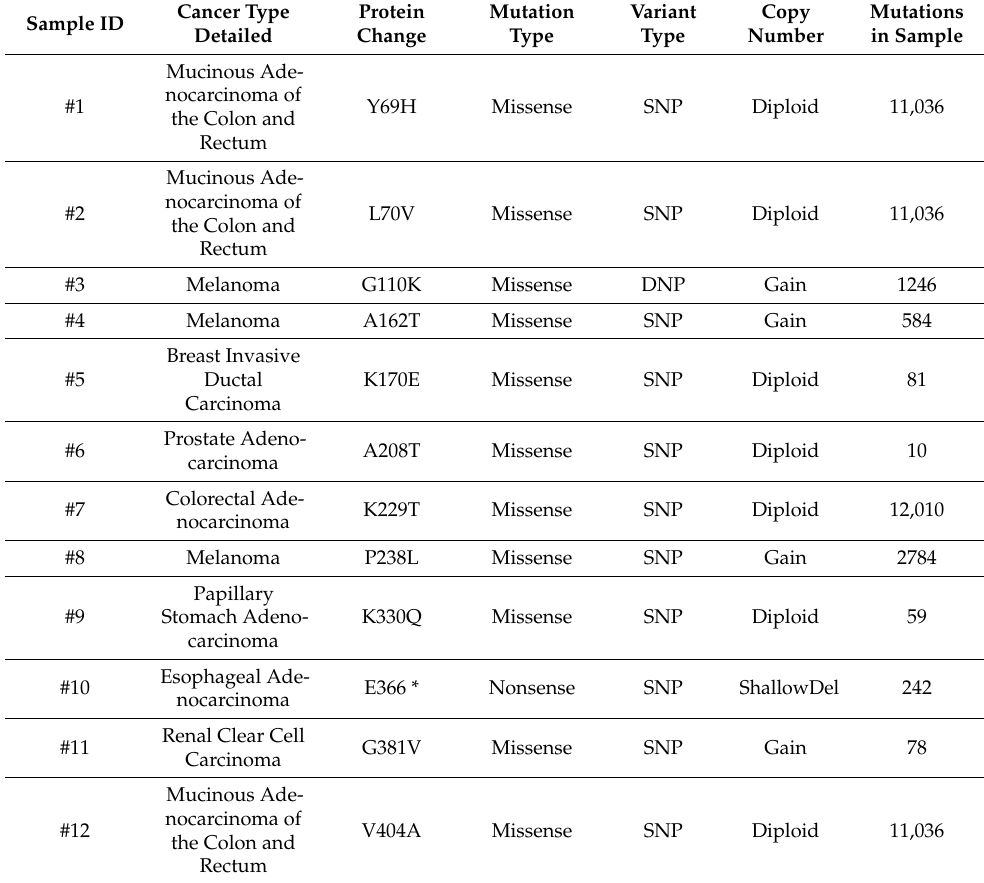
Table 1. NAMPT mutations in a pancancer study of whole